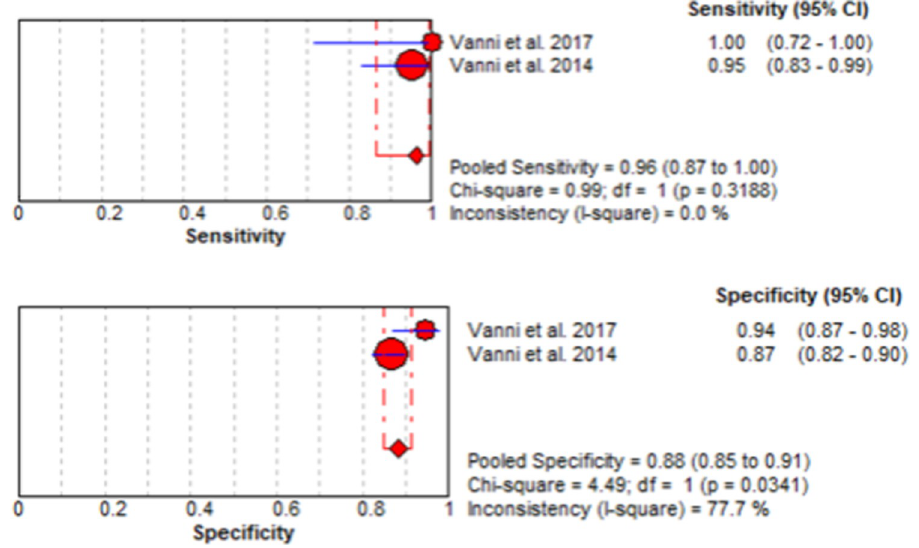
Fig 3. Meta-analysis of the diagnostic accuracy of the STANDING algorithm in trained emergency physicians. The forest plot shows the individual and pooled sensitivity and specificity with 95% confidence intervals. A random- effects model was used. Cochran’s Q test, chi-square with p values, and I 2 were calculated to estimate whether the variation between two studies was beyond that reasonably expected by